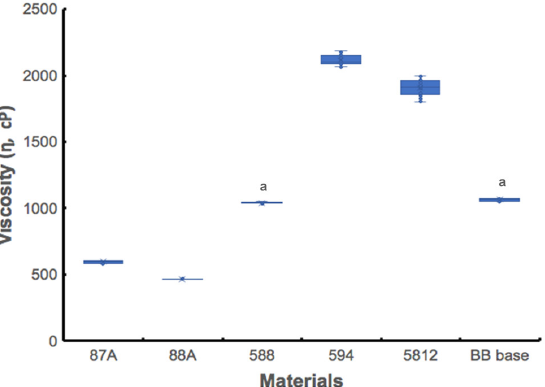
Figure 2. Viscosity of 5 UA-based photopolymer resins and a BB base. A same small letter indicates no static difference between materials.